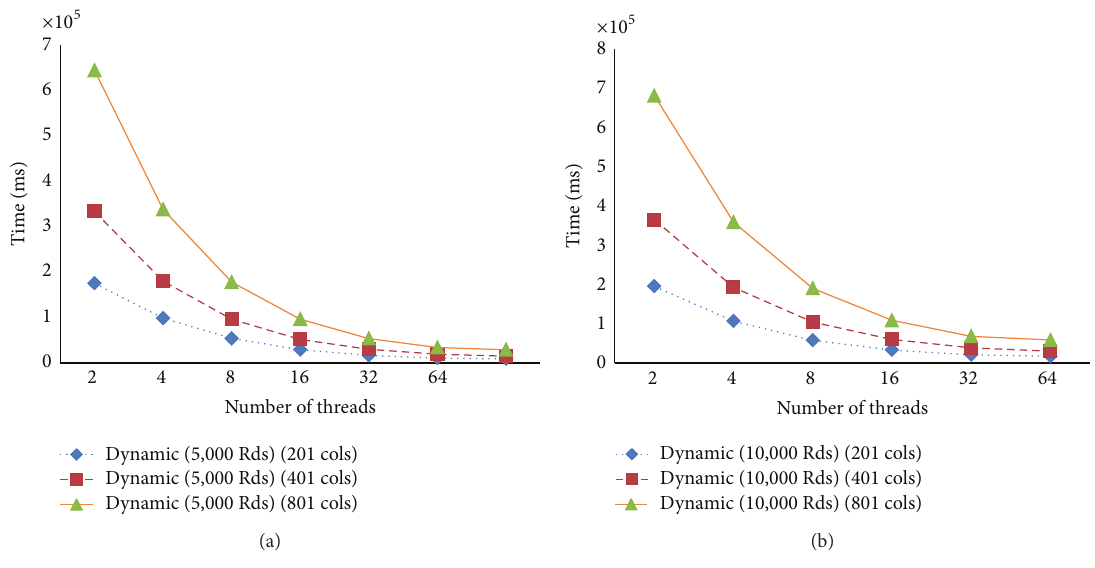
Figure 11: The computation time for 5,000 and 10,000 iterations, dynamic schedule varying number of